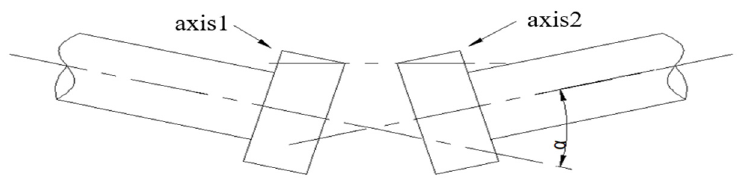
Figure 8. Angle misalignment.